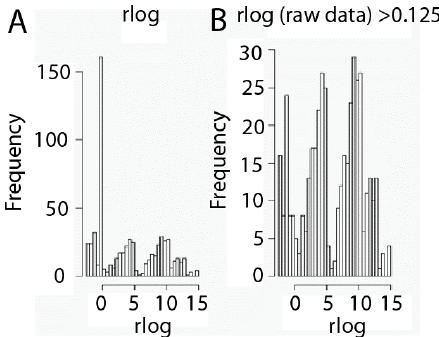
Figure 2. Gene expression level filtering. Histograms of data before ( A ) and after ( B ) the data set filtration process. Filtering was carried out by removing genes with a profile expression lower than 0.125 Reads per Kilobase per Millions of mapped reads (RPKM). Data are shown as rlog transformed.